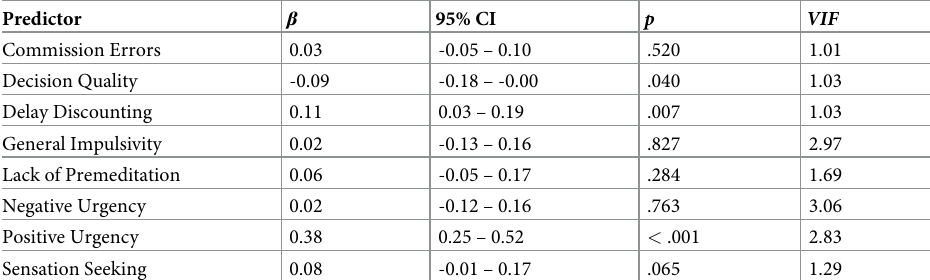
Table 5. Regression Model 4 results predicting the antisocial facet. Predictor